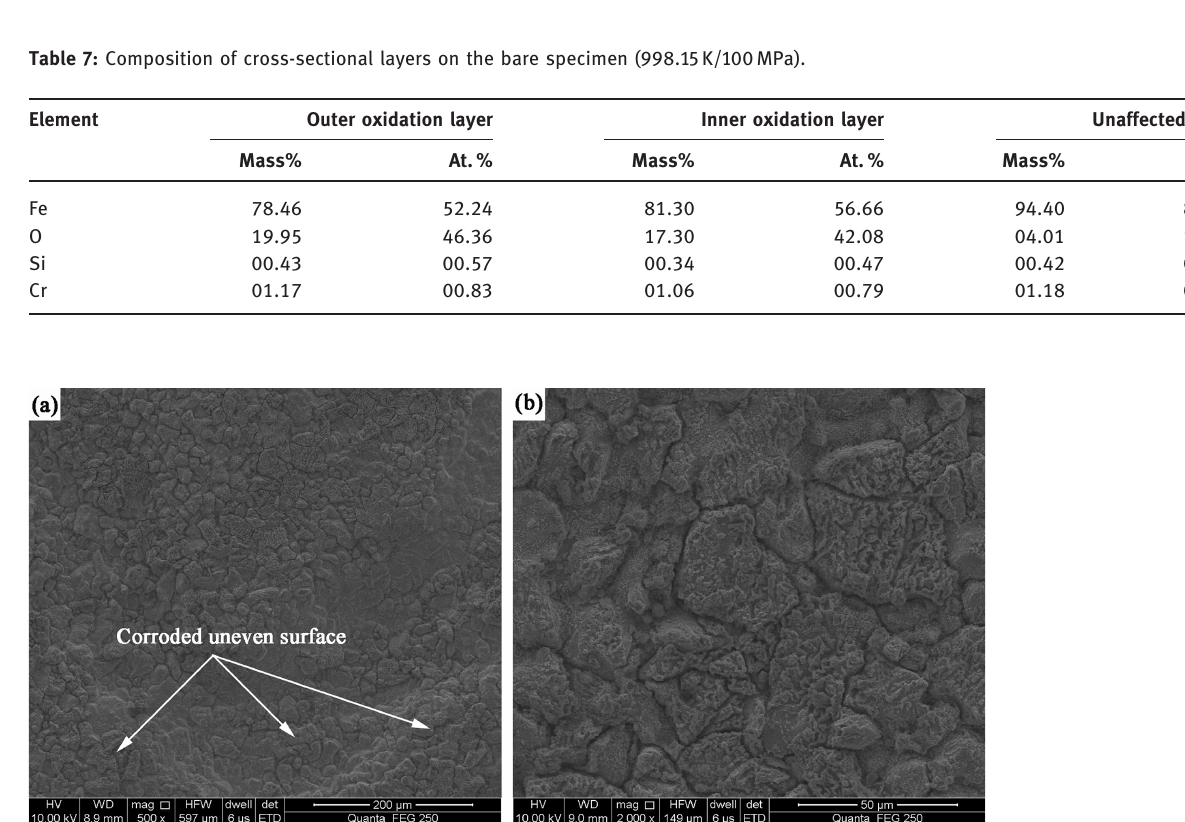
Figure 8: SEM micrograph of the (a) surface of transitional areas and (b) the amplification of grains and grain boundaries at 998.15K/100MPa.